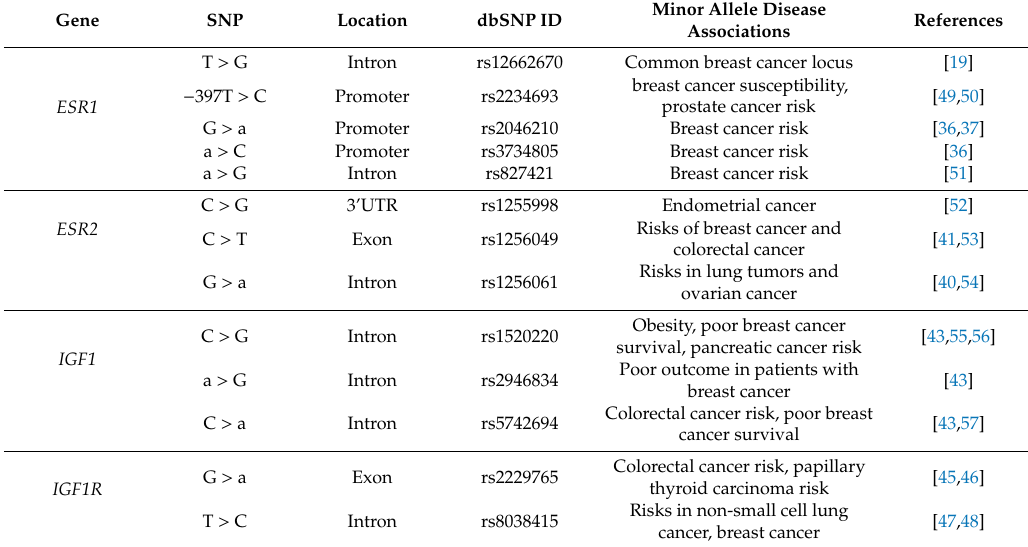
Table 2. Selection of the 13 candidate